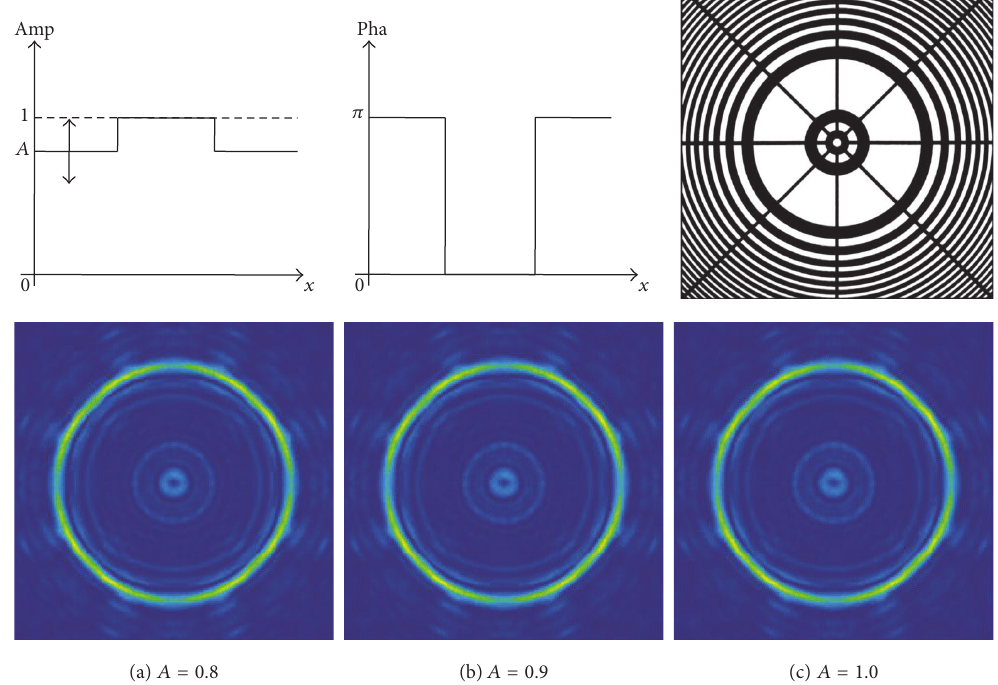
Figure 9: The simulation parameters (amplitude and phase diagrams together with the structure’sphase distribution). Intensity distributions (simulation results) for different material attenuation for scanned lens. Simulations were conducted for material attenuation values (1.0 value corresponds to no attenuation situation) as follows: 0.8, 0.9, and 1.0, shown in (a)–(c),